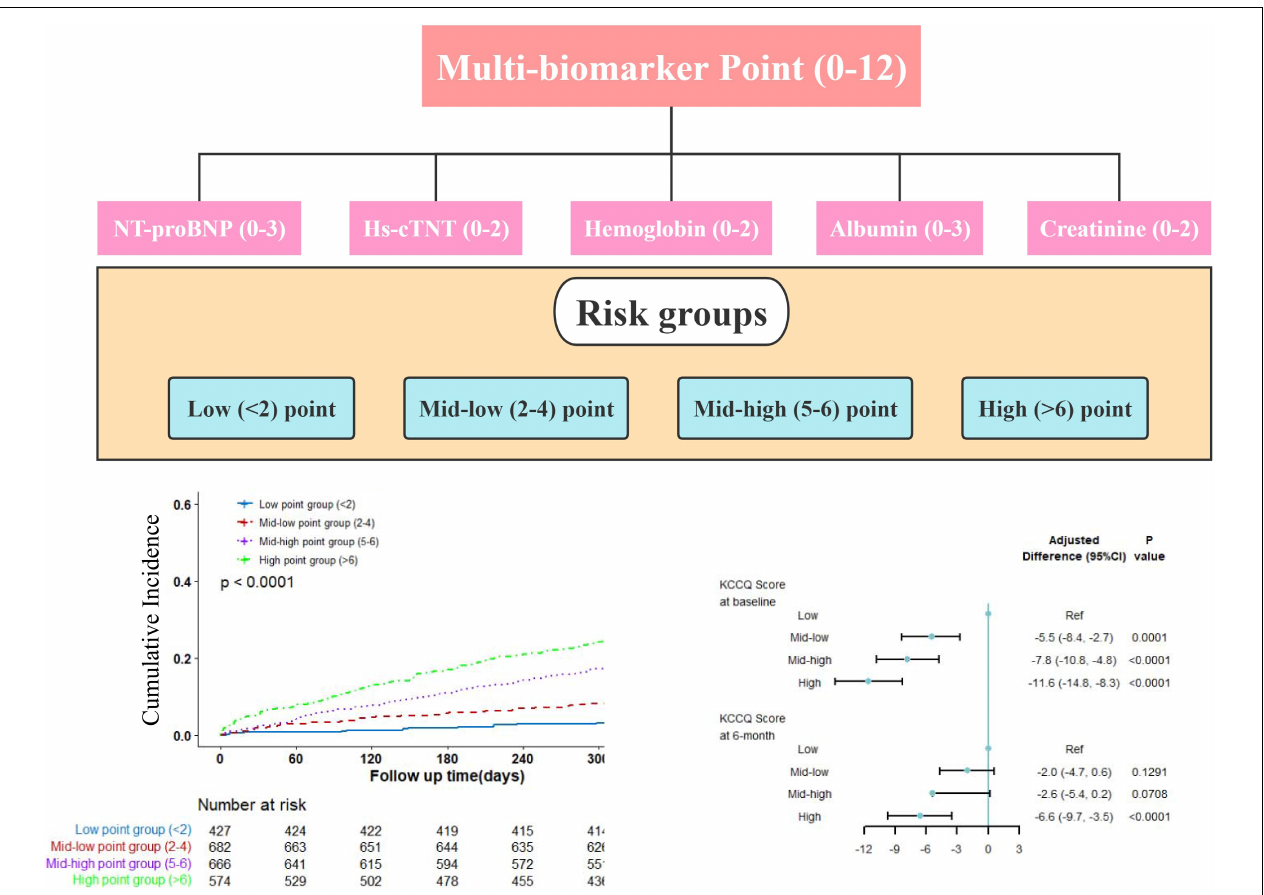
FIGURE 5 | Central illustration. Patients were classified into low, mid-low, mid-high, and high point groups by baseline biomarkers. Increasing multi-biomarker points were associated with excess risk of cardiovascular mortality and worse quality of